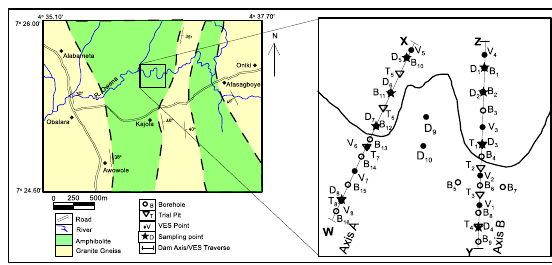
Figure 2: Proposed Kajola Dam Axes (Adekoya, 2008; Egwuatu,